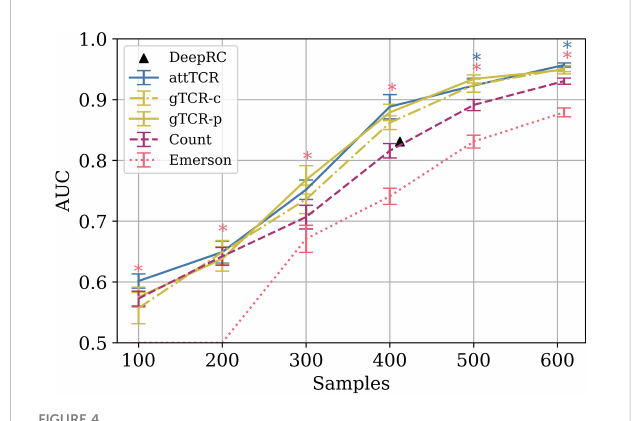
FIGURE 4 The AUC results of different models on different train sample sizes on the ECD (4). The results are over a 9 CV split of the training and the dev sets. The test set is the same for every model. Stars are used to mark statistically signi fi cant results using a t-test ( p <0.05). Pink stars represent the t-test between the Emerson model and the counting model, and blue stars represent the t-test between attTCR and the counting model. The results were also compared to the results reported for deepRC (8) (with a different experimental setup). For further result comparison to DeepRC and MotifBoost on the ECD, which have even lower AUC, see